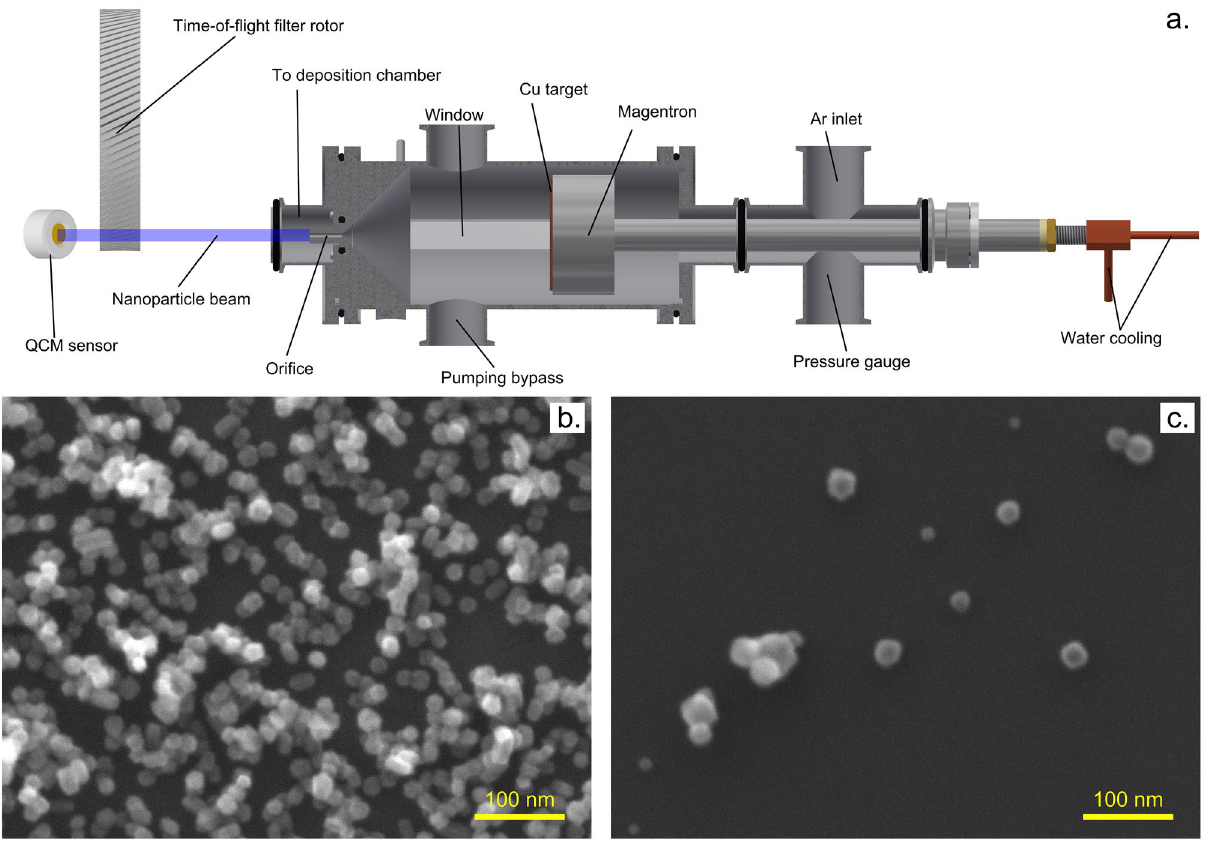
Figure 1. ( a ) Schematics of the nanoparticle source; ( b ) copper NPs deposited at pressure 20 Pa (mean size 18 nm, the standard deviation of mean 2.5 nm); ( c ) copper NPs deposited at pressure 100 Pa (mean size 26 nm, the standard deviation of mean 7 nm); The images have been obtained using a scanning electron microscope (SEM, JSM-7200F, JEOL). The samples have been deposited on single side polished silicon wafers and observed in secondary electron mode. The sizes have been determined by fitting NPs circumference by a circle.